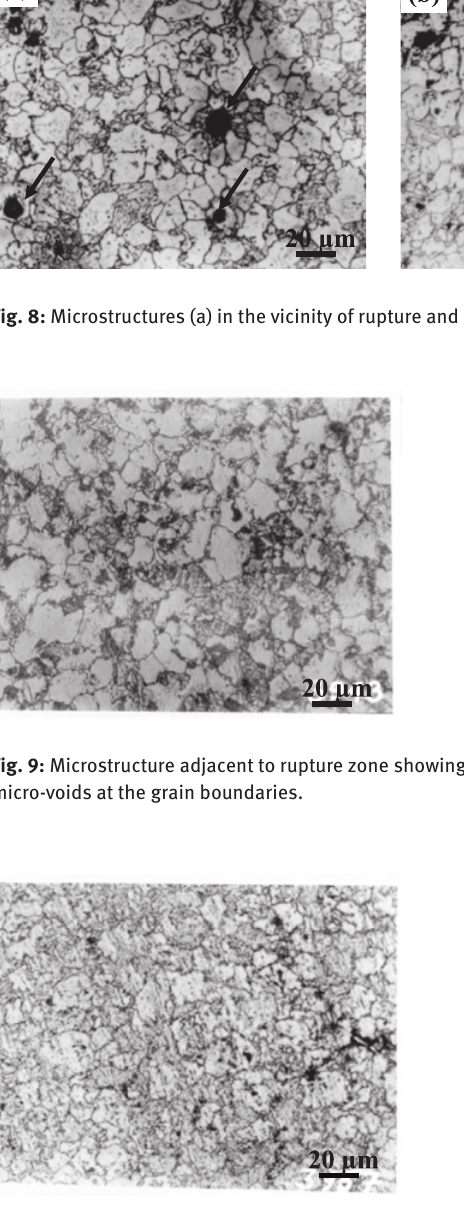
Fig. 10: Microstructure of unused tube